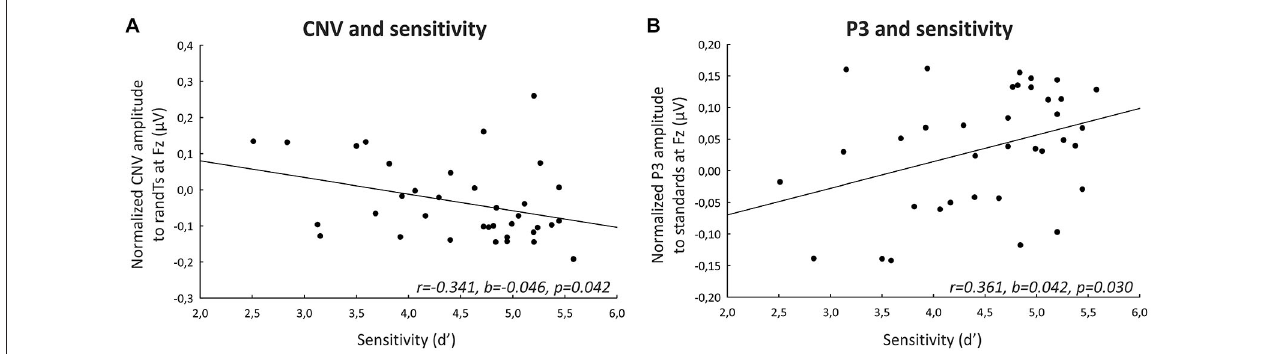
FIGURE 4 | Correlations with behavioral measures of sustained attention. (A) Normalized CNV ERP amplitudes (microvolts) preceding randTs at Fz plotted against sensitivity d (cid:48) . (B) Normalized P3 ERP amplitudes (microvolts) preceding standards at Fz plotted against sensitivity d (cid:48) . The solid lines represent the linear